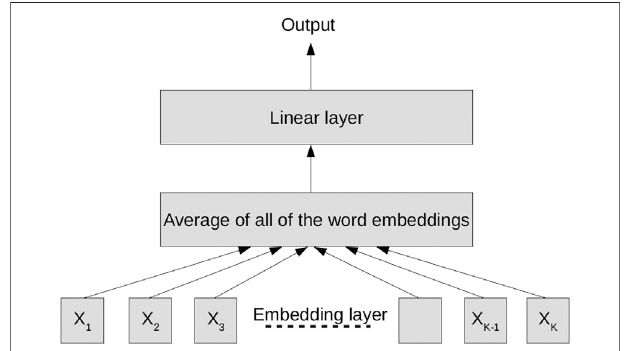
FIGURE 2 | fastText model (Joulin et al., 2017) with appended n-gram features ( X 1 , X 2 , X 3 , ... , X K − 1 , X K ) as input.